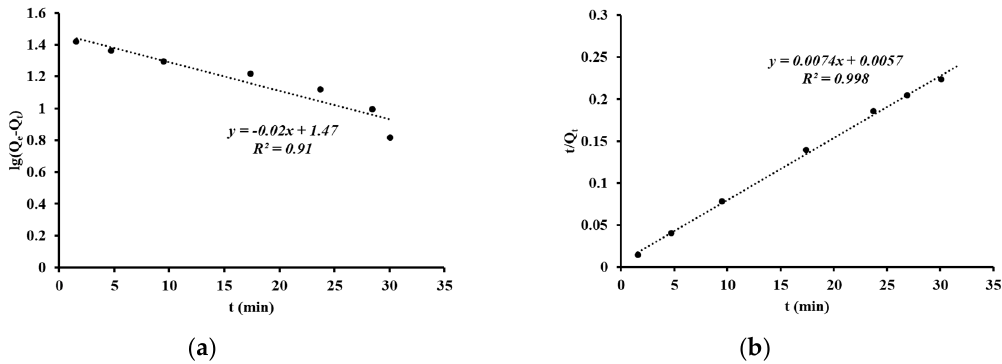
Figure 7. The kinetics of sorption by the porous polymer composite of 1/6-70-30 in the coordinates of the pseudo-first ( a ) and ( b ) the pseudo-second order models.